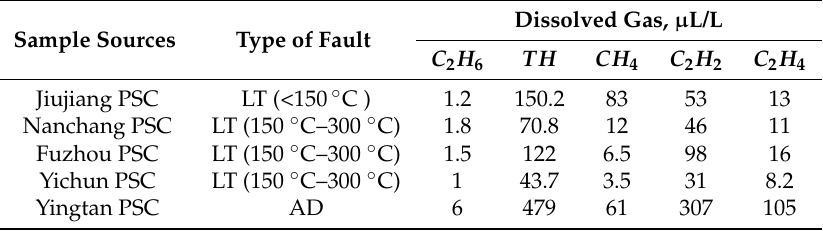
Table 1. Part of the original data of power transformer fault type judged by China electric power research institute with the DGA